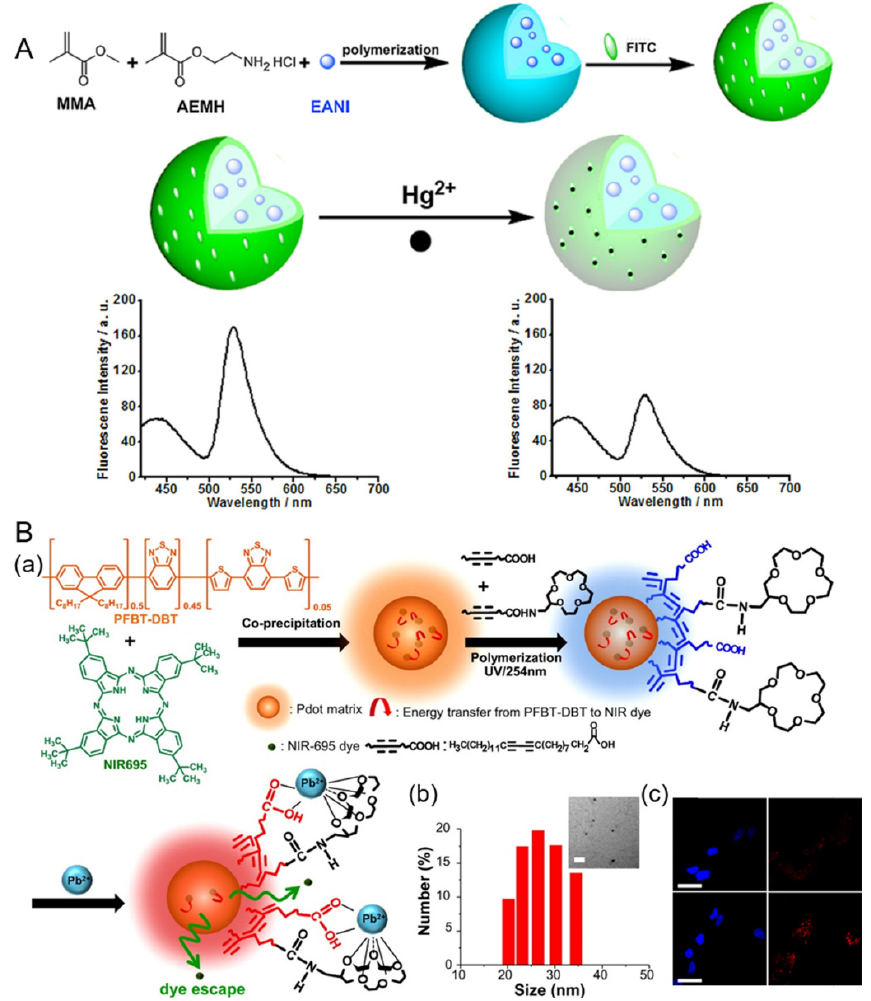
Figure 6. ( A ) Schematic illustration of preparation of a PNP-based ratiometric fluorescent Hg 2+ sensor. Reproduced from [74], with permission from Elsevier, 2016. ( B ) ( a ) First, semiconducting polymer PFBT-DBT and NIR695 dyes were mixed well in THF and then coprecipitated in water under vigorous sonication to form dye-encapsulated PFBT-DBT Pdots. A mixture of carboxyl- and 15-crown-5-functionalized polydiacetyelenes (PDAs) were then coated onto the surface of the Pdots for subsequent Pb 2+ sensing. ( b ) The hydrodynamic diameters of PDA-enclosed dye-doped Pdots were measured by DLS. The inset shows their corresponding TEM image. The scale bar represents 100 nm. ( c ) Confocal microscopy imaged HeLa cells labeled by PDA-enclosed NIR695-emdedded Pdots through endocytosis (first row). Images of HeLa cells which were incubated with 20 µ M Pb 2+ for 2 h (second row). Blue fluorescence is from nuclear counterstain Hoechst 34580, and red fluorescence is from Pdots. The scale bars are 30 µ m. Reproduced from [78], with permission from the American Chemical Society,